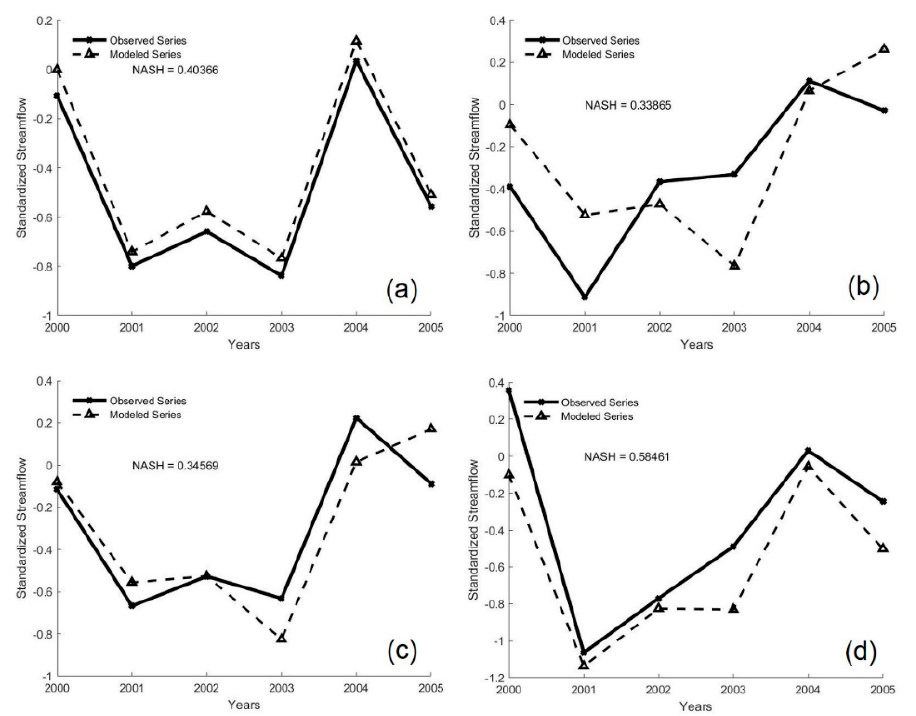
Figure 5. Performance of the linear regression model in the estimation of the annual affluent natural flow of the reservoirs: ( a ) Queimado, ( b ) Moxotó, ( c ) Paulo Afonso Complex, and ( d ) Xingó for the period from 2000 to 2005.